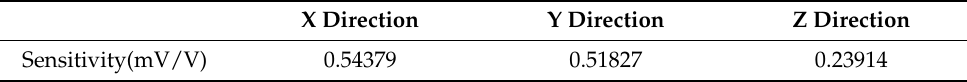
Figure 5. Three-direction calibration results.